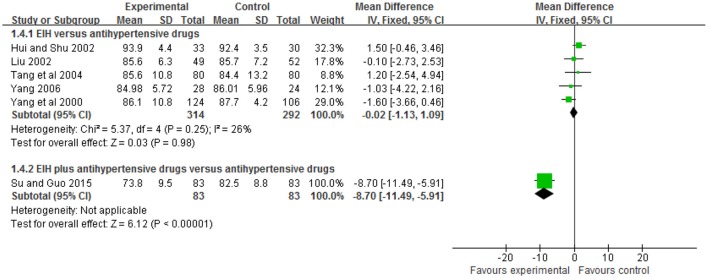
The forest plot of comparison of two groups for the outcome of diastolic blood pressure.